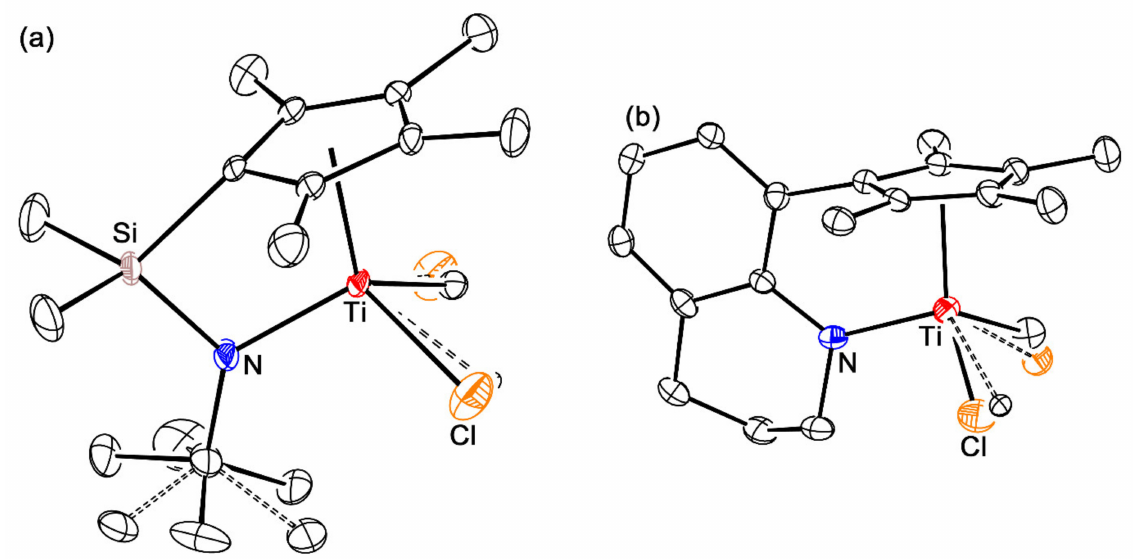
Figure 3. Structures of 5 -TiCl(Me) ( a ) and 6 -TiCl(Me) ( b ) revealed by X-ray